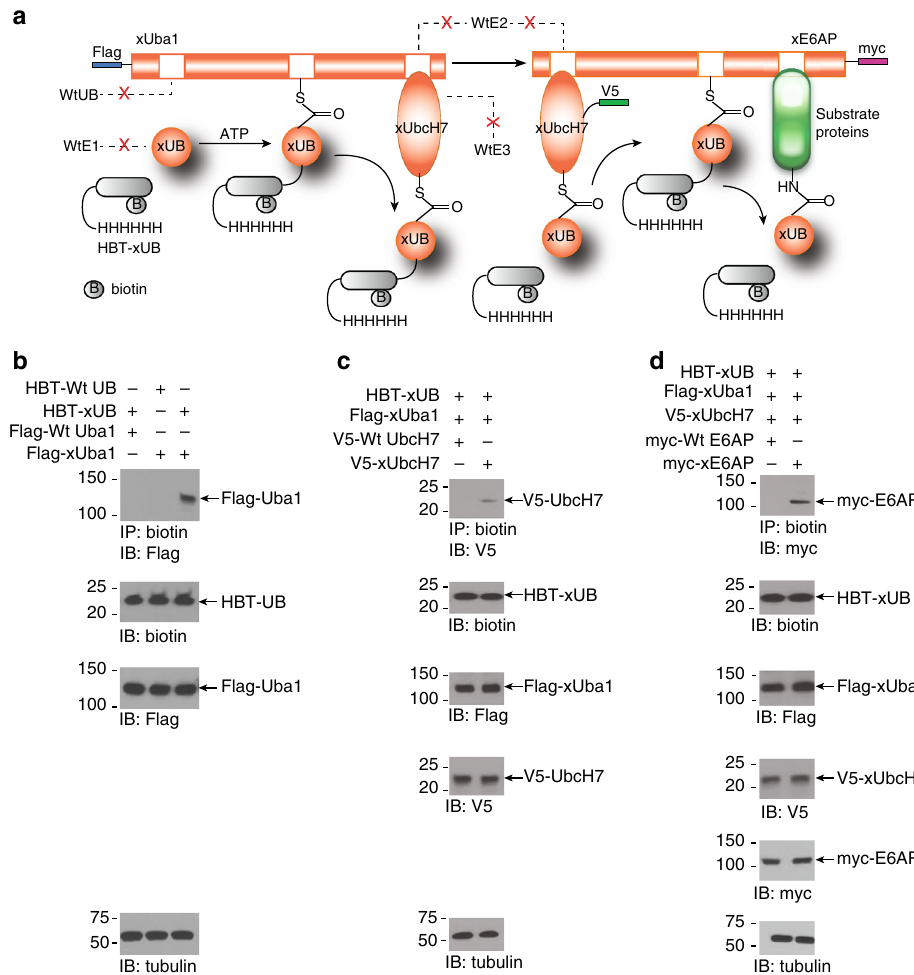
Fig. 4 Orthogonality of the E6AP OUT cascade with wt Uba1-UbcH7-E6AP cascade in HEK293 cells. a Scheme showing exclusive transfer of xUB through the OUT cascade of E6AP. xUba1, xUbcH7 and xE6AP are tagged with Flag, V5 and myc tags, respectively. Dotted lines with a red “ X ” designate none interactions between OUT components and the native E1, E2, and E3 enzymes. xUB is tagged with biotin and 6× His tags (HBT-xUB). b xUB and xUba1 formed xUB – xUba1 conjugate in HEK293 cells. As a result of conjugate formation, fl ag-xUba1 could be copuri fi ed with HBT-xUB by binding to streptavidin beads. In contrast, fl ag-wt Uba1 could not be copuri fi ed with HBT-xUB, neither could fl ag-xUba1 be copuri fi ed with HBT-wt UB in the cells co-expressing the UB-E1 pairs. This suggests that the crossover xUB-wt Uba1 or wt UB-xUba1 pairs are not active in the cell. c xUB could be transferred through xUba1- xUbcH7 pair to form xUB – xUbcH7 conjugate in the cell. Due to the conjugate formation, V5-xUbcH7 could be copuri fi ed with HBT-xUB from cells expressing HBT-xUB, fl ag-xUba1 and V5-xUbcH7. In contrast, the expression of HBT-xUB and the crossover pair of xUba1 – wt UbcH7 would not